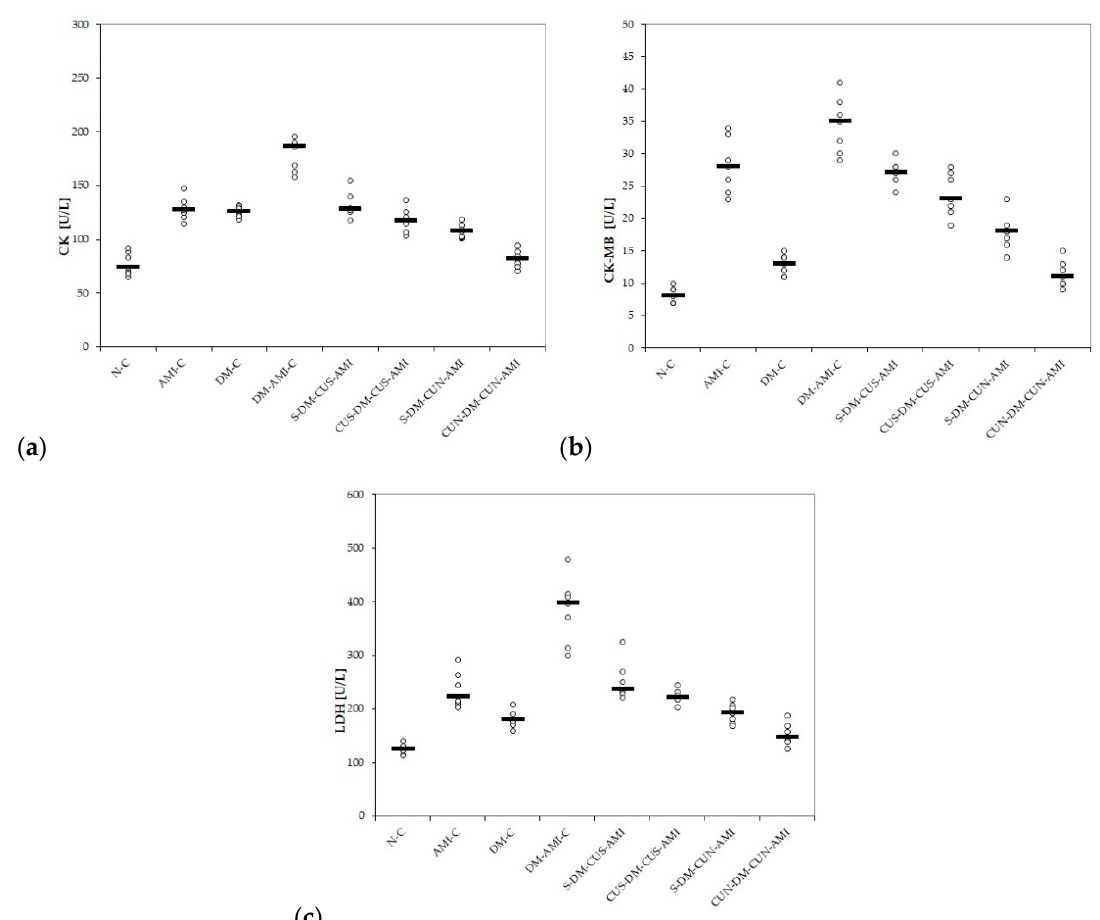
Figure 1. Variation of serum levels of myocardial infarction enzymes by groups: ( a ) CK (creatine kinase), ( b ) CK-MB (creatine kinase-MB), and ( c ) LDH lactate dehydrogenase by groups. Notes: The circles represent the individual values, and the horizontal line is given by the median. Abbreviations: N = normal; C = control; AMI = acute myocardial infarction; DM = diabetes mellitus; S = saline; CUS = curcumin solution in a dose of 200 mg / kg bw; CUN200 = curcumin nanoparticles solution in a dose of 200 mg / kg Table 4. P -values for comparisons between the study groups for myocardial infarction enzymes.